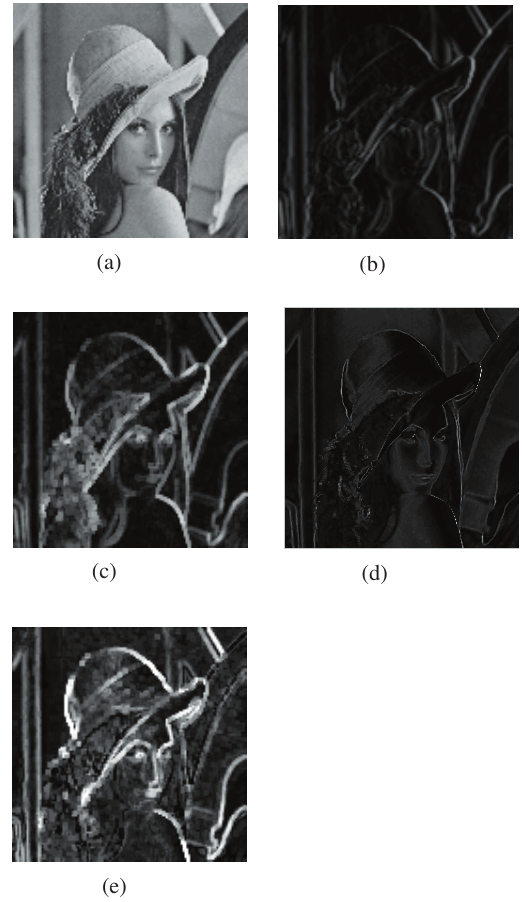
Fig. 10. : a) Lena image, b) edge image using fuzzy morphology, c) edge image using the interval valued fuzzy set, d) edge